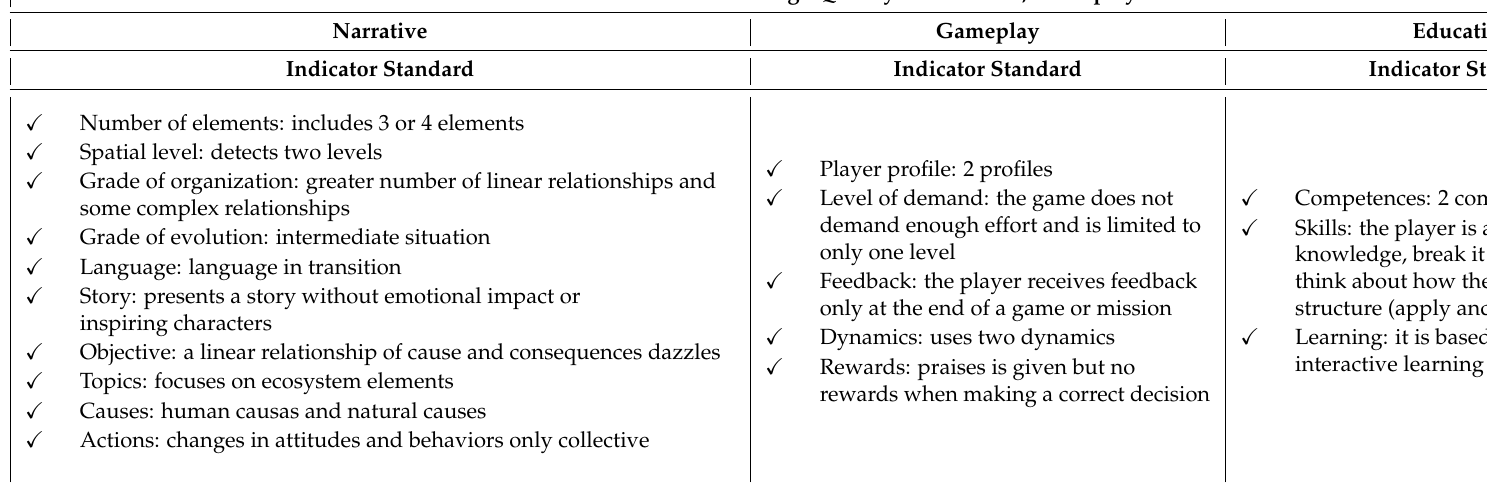
Level 2. Good Games of Medium-High Quality in Narrative, Gameplay and